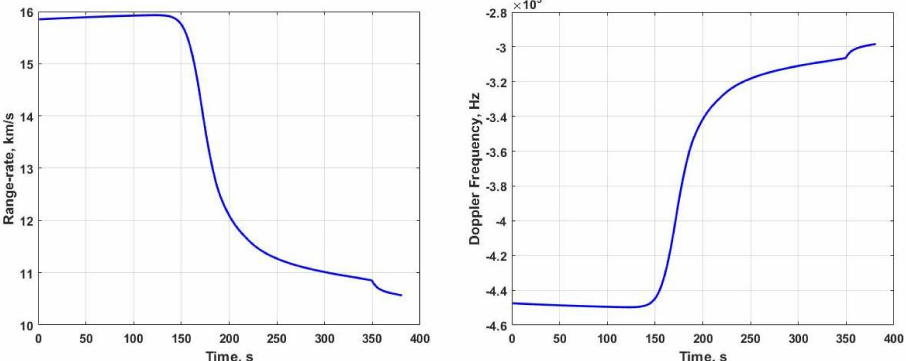
Figure 3. Computed Doppler values for Mars Science Laboratory (MSL): ( a ) Range-rate; ( b ) Doppler frequency (X-band).